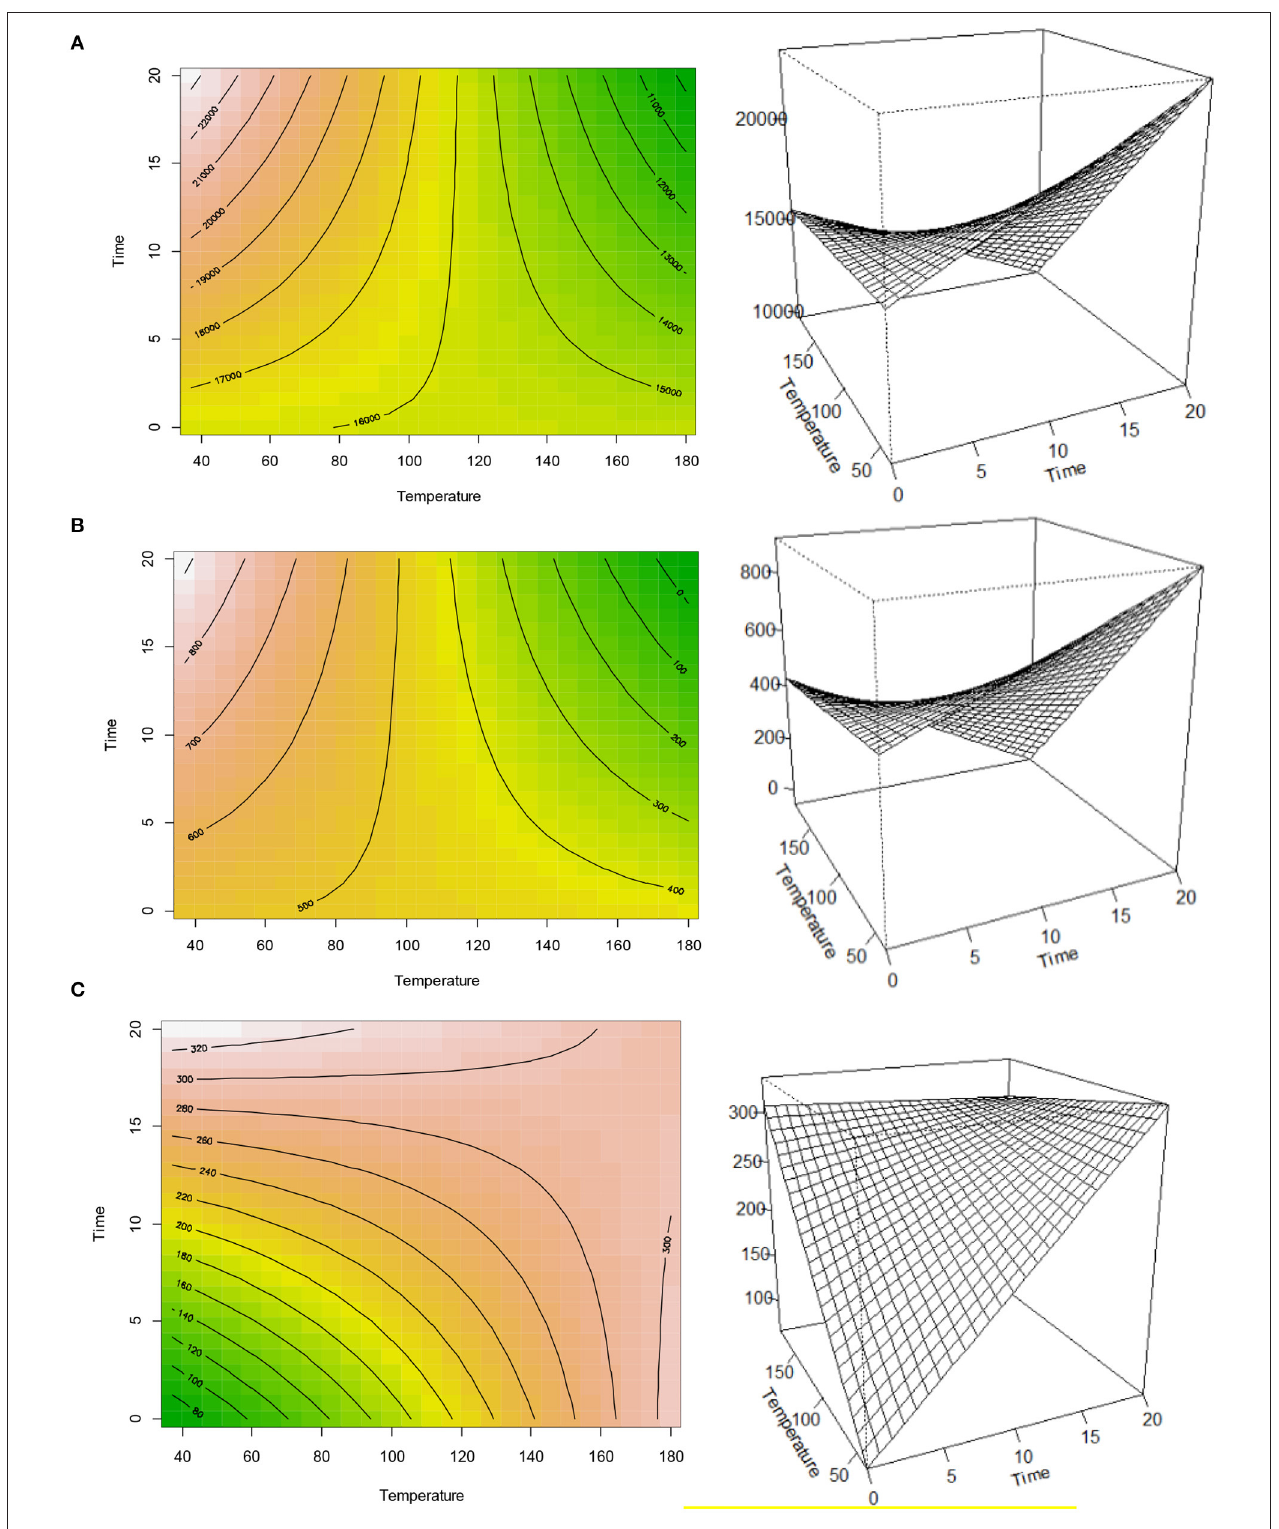
FIGURE 2 | Contour-plots and response surface analysis of time (minutes)-temperature ( ◦ C) pre-treatment on sinapine (A) , sinapic acid (B) , and canolol (C) .